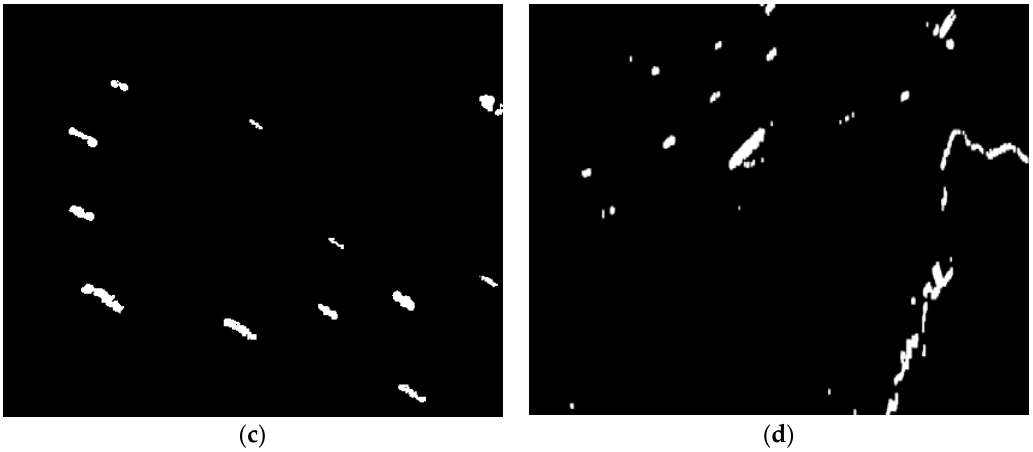
Figure 17. The binary significant images after PSMEWT. ( a ) Cloud coverage; ( b ) visible swell; ( c ) low contrast; and ( d ) simple sea.